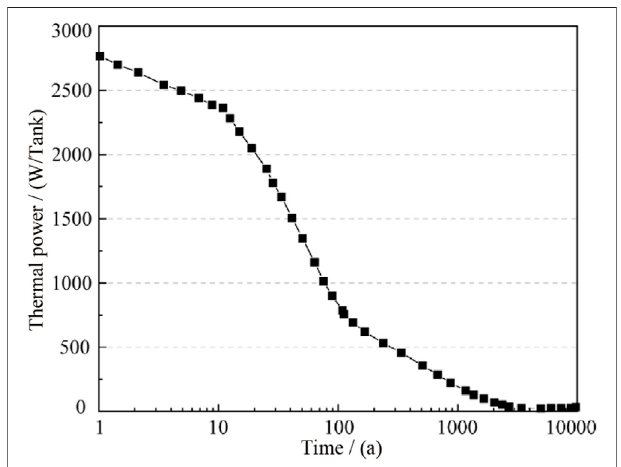
FIGURE 9 | Exothermic decay function of solidi fi ed glass of high-level radioactive